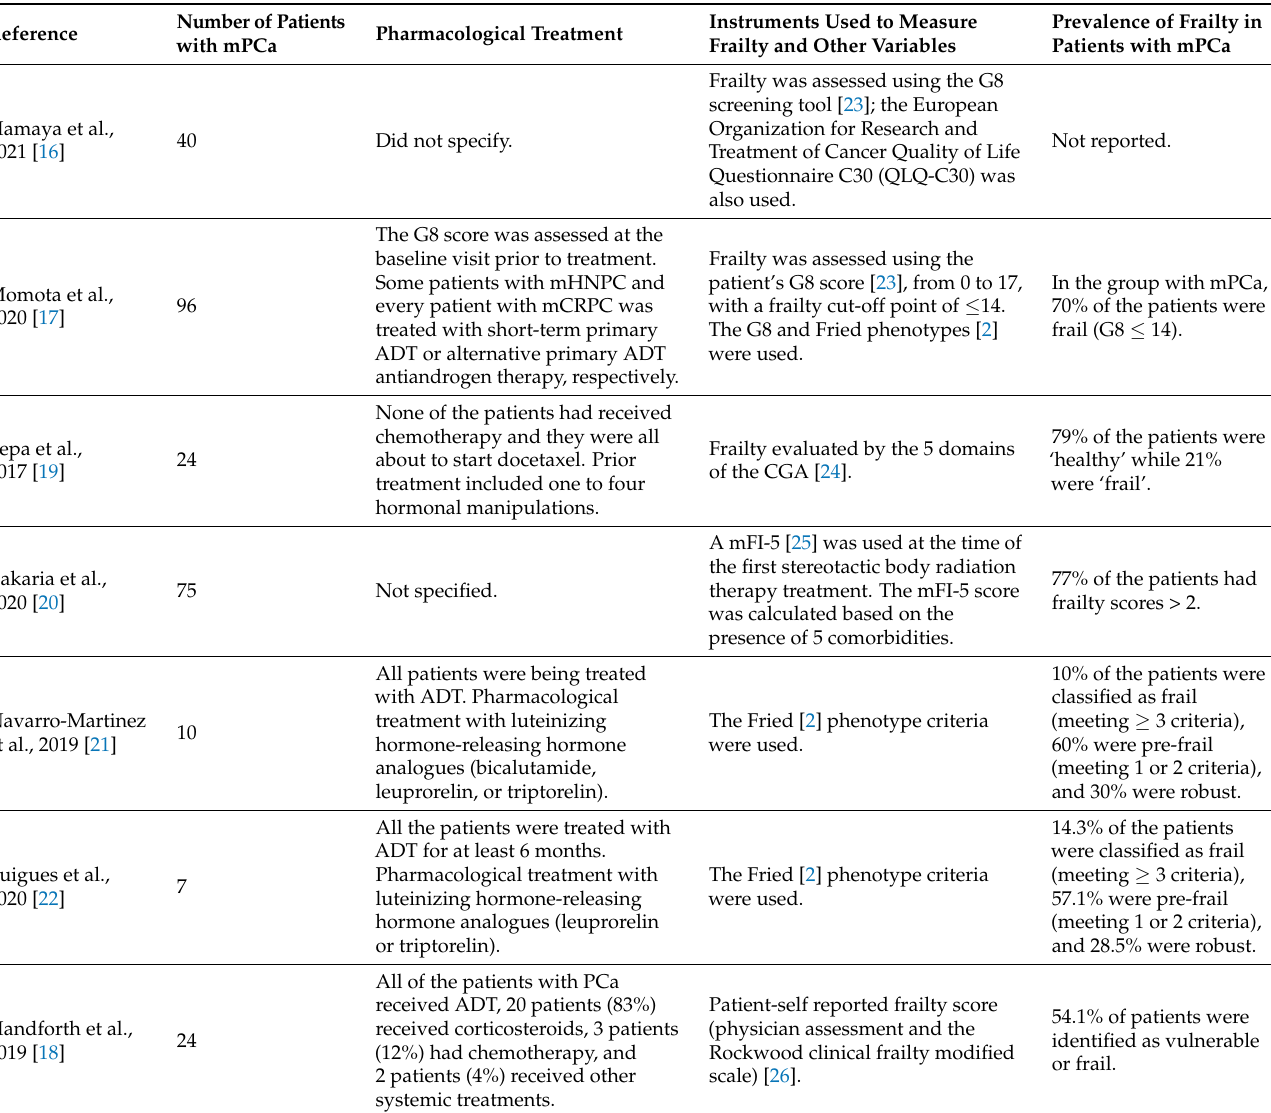
Table 1. The mean characteristics of the selected